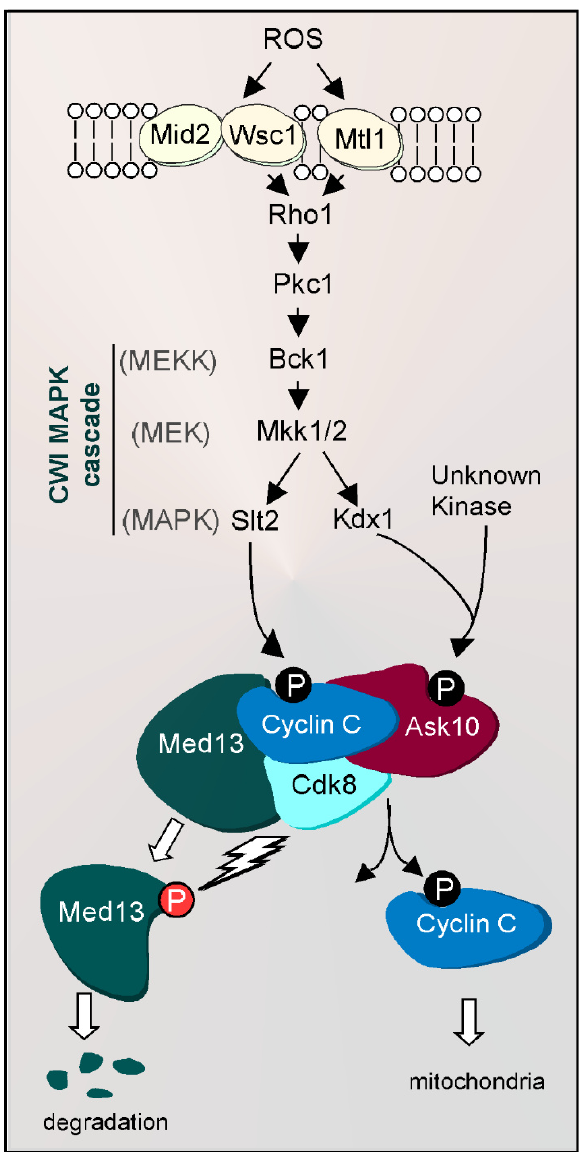
FIGURE 2: Regulation of cyclin C relocalization by the cell